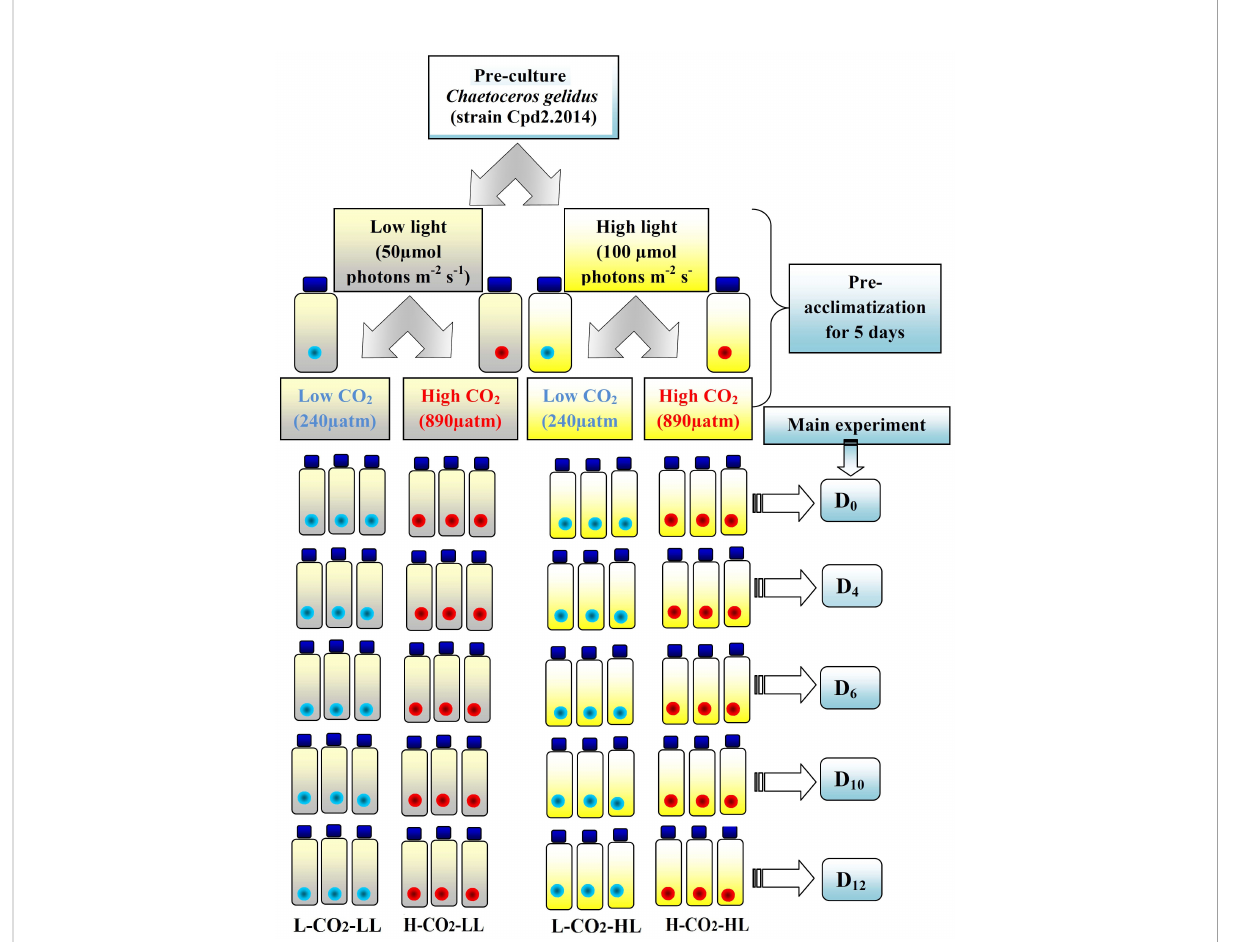
FIGURE 1 Schematic representation of the experimental pattern showing the replicates (3) and variables for each treatment. The blue and red marked bottles represent the low CO 2 (L-CO 2 ) and high CO 2 (H-CO 2 ) levels, respectively. The light and bright yellow shades indicate the low light (LL) and high light (HL) levels. The right side blue shaded boxes show the day of